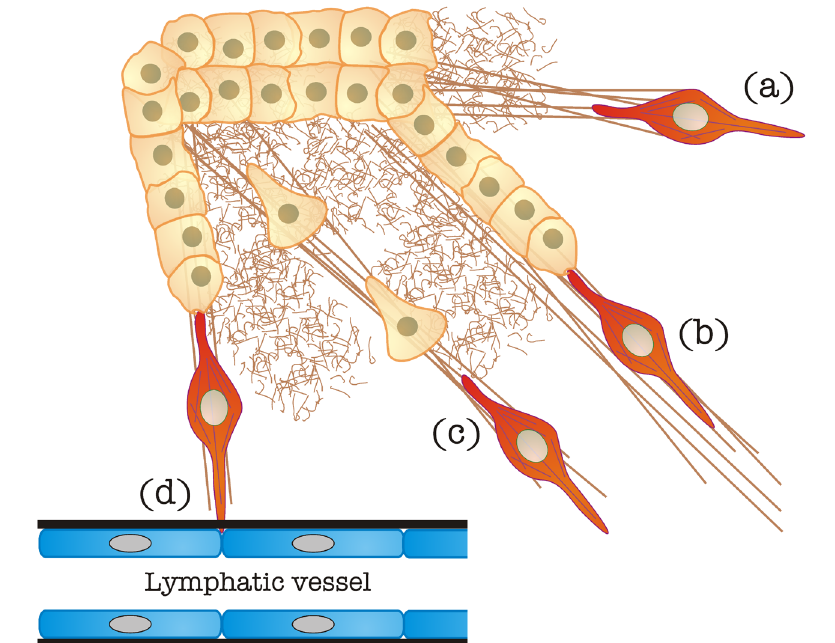
Figure 2 . CAF-mediated egress of tumor cells from the primary mass. (a) Matrix stiffening caused by CAFs, as also shown in Figure 1 ; (b) “locomotive”-based chain migration, in which CAFs (in red, it may also represent a TAM, see section “ CAF “locomotives” drive tumor cells toward egress sites to favor metastatic dissemination” for details) drag chains of tumor cells along matrix bundles; (c) matrix stiffened by CAFs can be used by individual cancer cells to undergo mesenchymal migration; (d) CAFs can degrade the basement membrane (in black) of blood/lymphatic vessels to favor tumor cell intravasation CAFs trigger immunosuppression: a key role for TGF-β at the